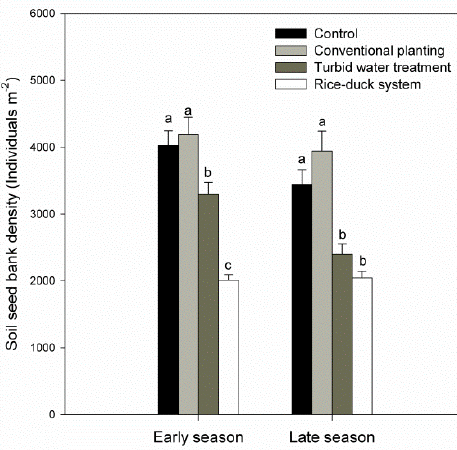
Figure 3. Soil seed bank density in the early and late seasons of rice growth under the treatments and control. Bars present the mean and error bars present the standard error ( n = 3). Di ff erent lowercase letters above bars indicate statistically significant di ff erences among treatments in the early or late rice growing season. Significance level was set at p < 0.05.